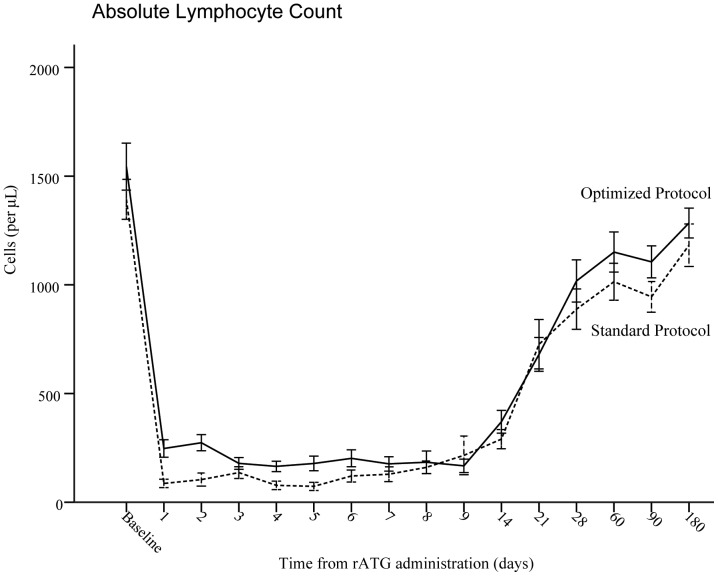
Absolute lymphocyte count (mean±SE) following rATG administration.The degree and duration of lymphopenia were similar between Standard rATG (dotted line) and Optimized rATG (solid line) 9 days and 6 months following rATG administration.